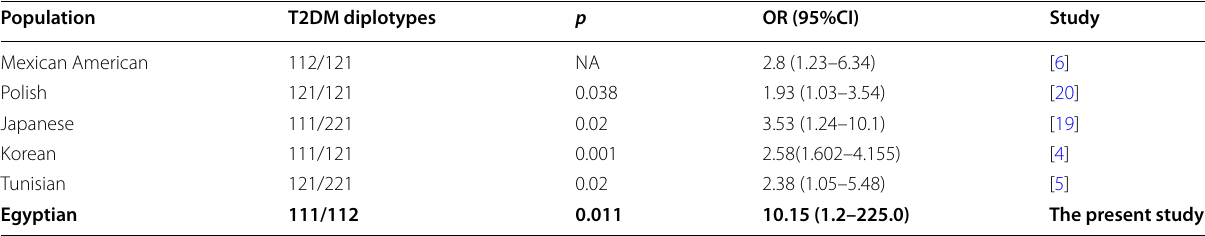
Table 4 CAPN10 haplotype combination (diplotype) associated with high T2DM risk among different